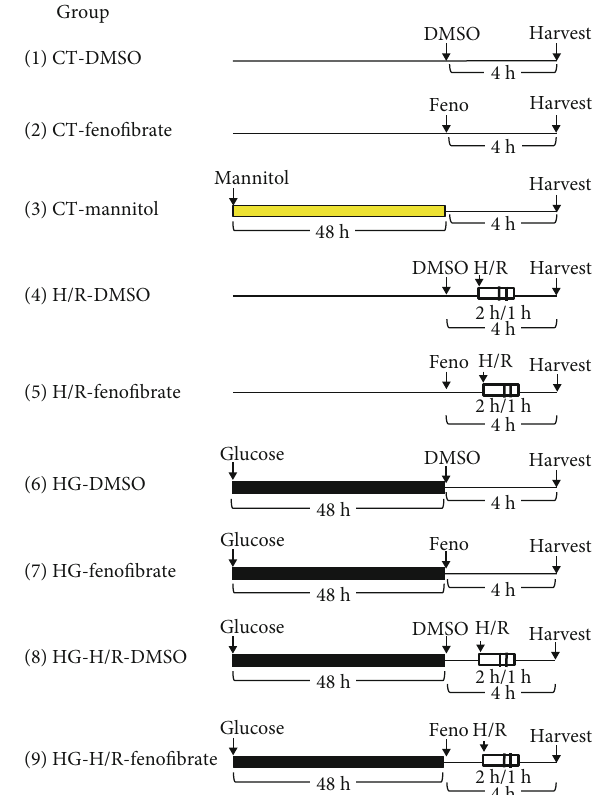
Figure 1: Schematic representation of the experimental group design. Primary cardiomyocyte cultures were divided into 9 groups. Mannitol (19.5mM) and high glucose (25 mM) were administered 48 hrs before feno fi brate (10 μ M) or DMSO (0.1%) treatment. Exposition time for either feno fi brate or DMSO treatment was 4 hrs, with or without hypoxia-reperfusion maneuver, before harvest. CT = control; H/R = hypoxia- reperfusion; HG = high glucose; DMSO = dimethylsulfoxide 0.1%; Feno = feno fi brate 10 μ M. Yellow bar represents mannitol- treatment period, black bar represents glucose-treatment period, white bar represents hypoxia period, and dashed bar represents reoxygenation